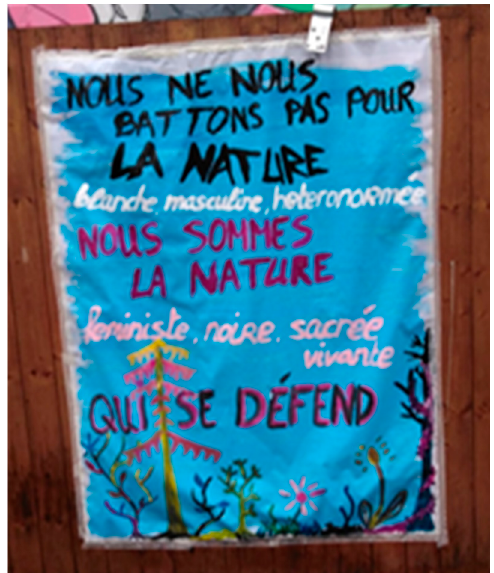
Figure 2. Photo by Alexandre Grandjean, Lausanne, 16 June 2020.